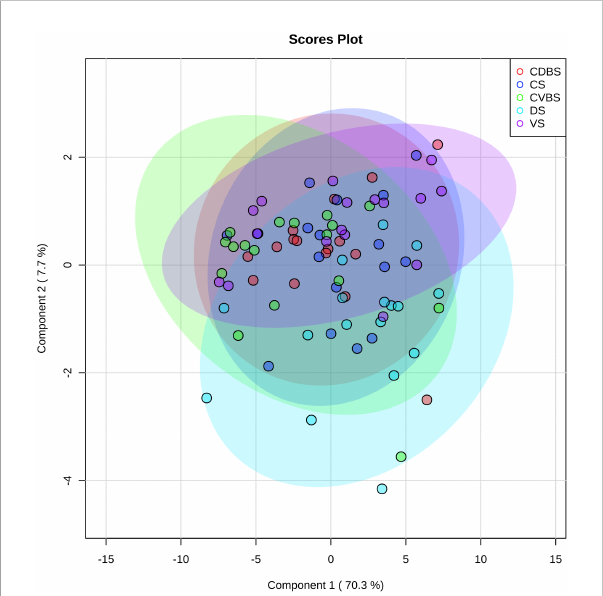
FIGURE 11 Partial least-square discriminant analysis of metabolites among all fi ve rumen sacs. Partial least-square discriminant analysis of the rumen liquid samples, where each individual cow ’ s rumen sac is denoted by a dot of a speci fi c color. Purple represents the VS, bright blue represents the DS, green represents the CVBS, dark blue represents CS, and red represents the CDBS. The large transparent circles represent a 95% con fi dence interval of each rumen sac, where the colors correspond with the dot color. There is signi fi cant overlap among each of the rumen sacs, indicating no unique metabolic pro fi le among each rumen sac.